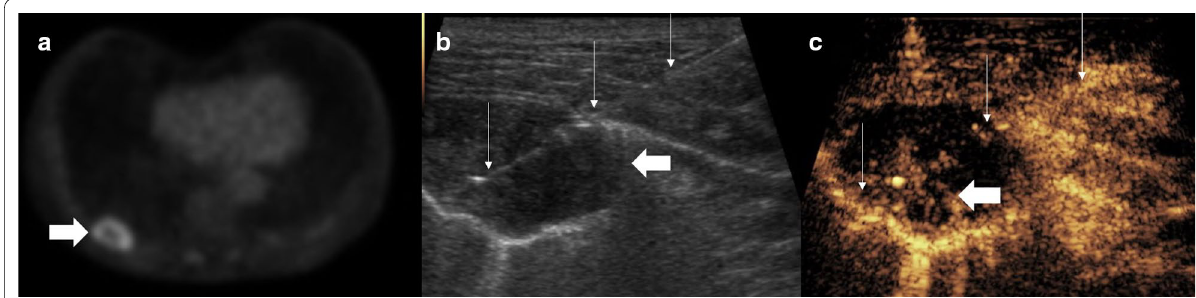
Fig. 5 Patient with squamous cell carcinoma. a PET‑CT shows a peripherally avid lesion with no central avidity (arrow). b , c Simultaneous B mode and CEUS images as the biopsy is performed. B mode demonstrates a hypoechoic lesion (thick arrow) with the biopsy needle within the lesion (thin arrow). The contrast image ( c ) shows the biopsy (thin arrows) is taken from the deep area of enhancement and therefore viable tissue (thick arrow)